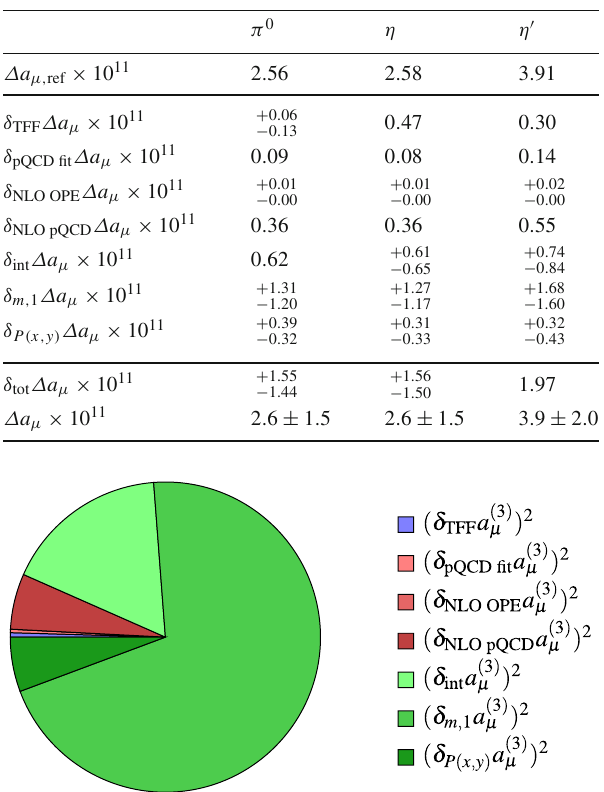
Table 1 The effects on a HLbL μ of longitudinal SDCs assuming that the low-energy region is dominated by ground-state pseudoscalar poles, whosecontributionsaretakenasinput.Ineachflavorchanneltheresults are presented as the shifts Δ a μ, ref with respect to the pole contributions for a specific reference set of parameters and a list of uncertainties corresponding to different choices for each of these parameters. In the last two rows, these uncertainties are added in quadrature and the final range is symmetrized. See main text for details